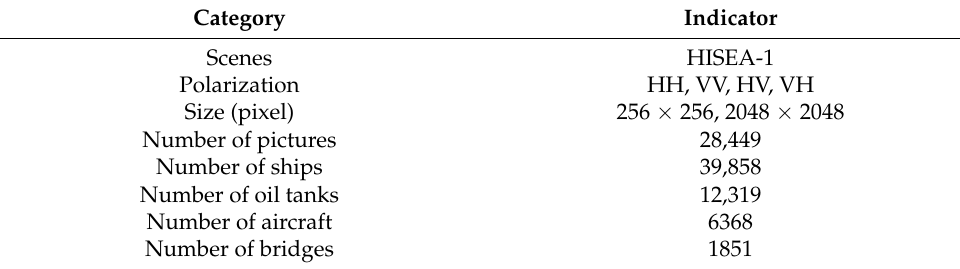
Table 4. Details of MSAR